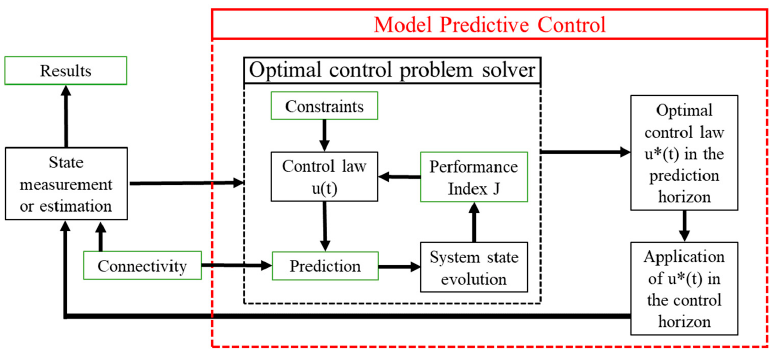
Figure 1. Synthetic flow diagram of a general model predictive control.